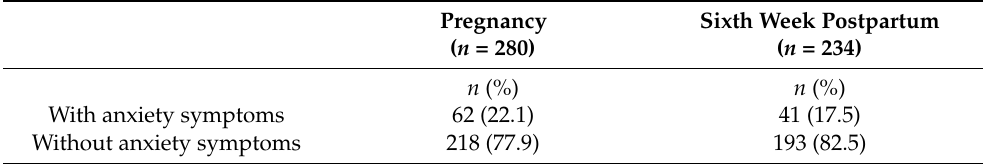
Table 2. Perinatal anxiety symptom rates.